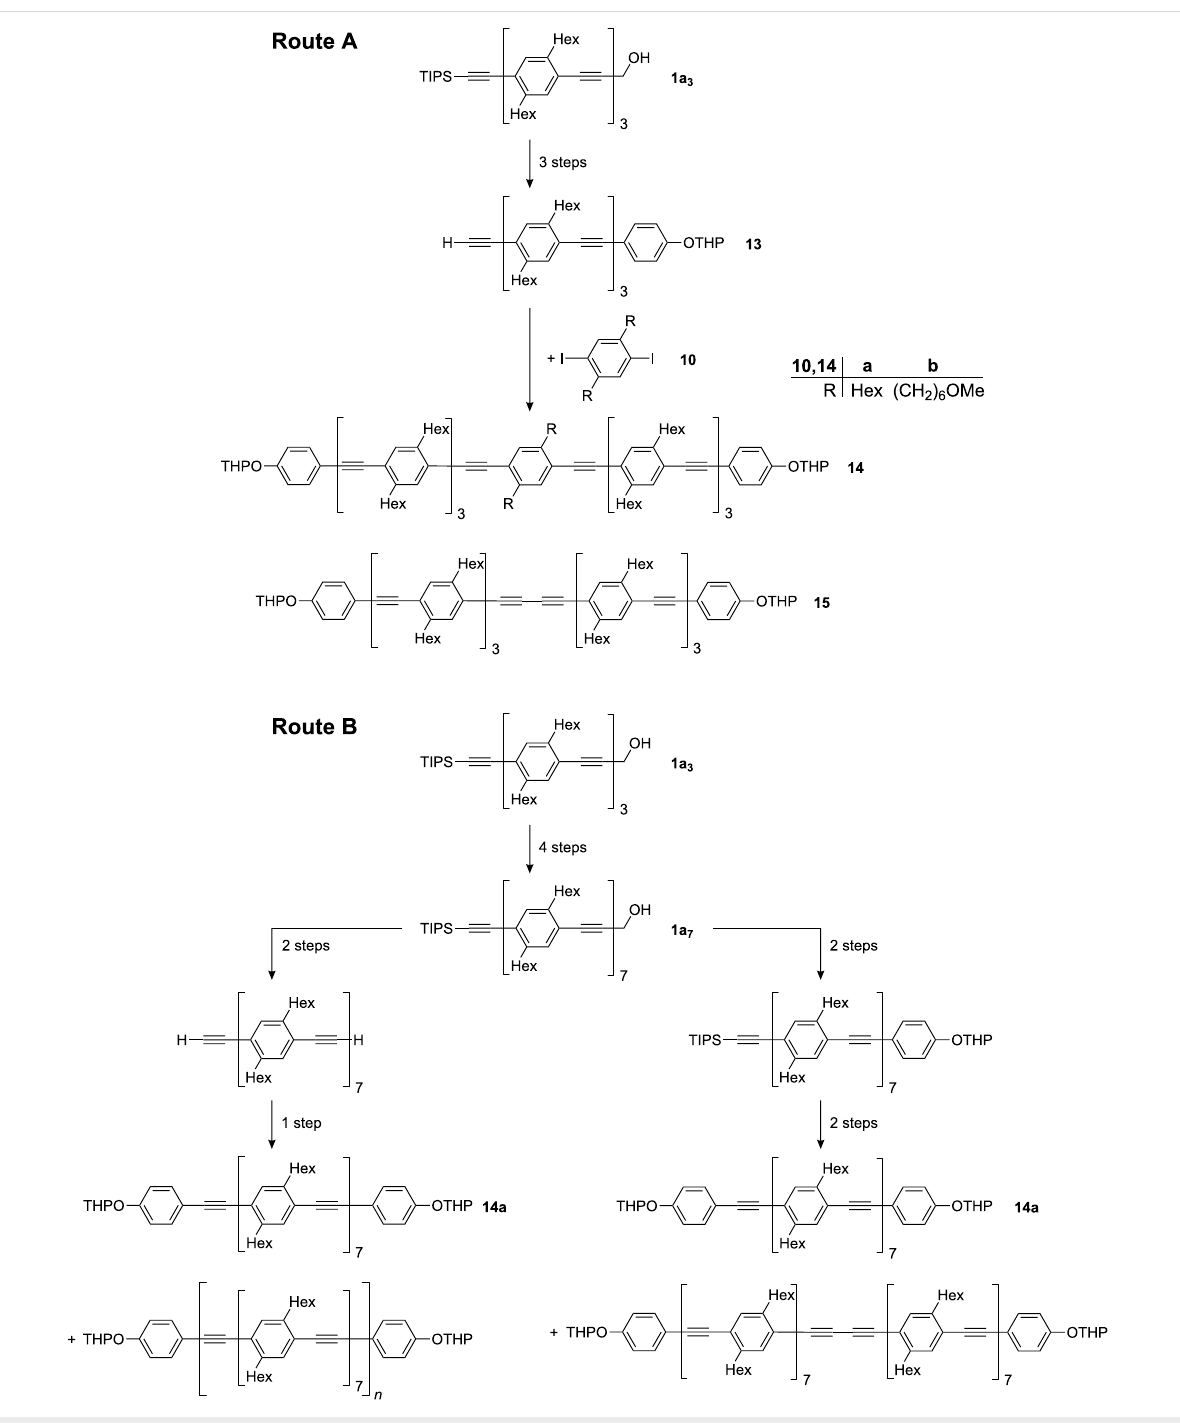
Scheme 6: Different routes to compound 14 , a representative of the large group of functionalized